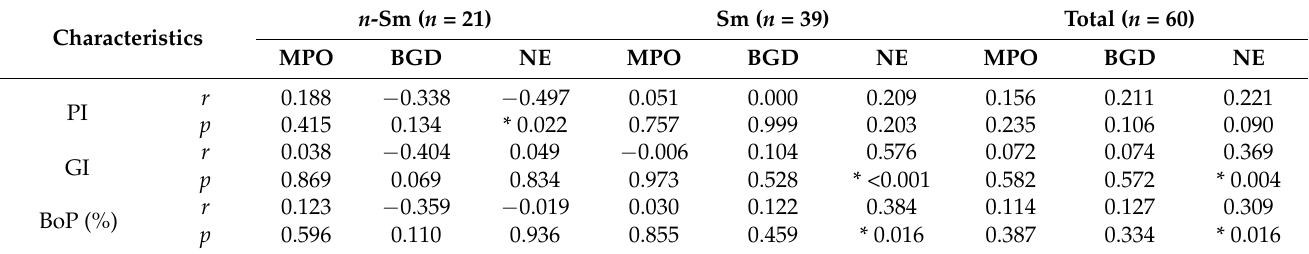
Table 4. Correlations between Biochemical Parameters and Clinical Parameters in Smokers, Non-Smokers and all Participants.